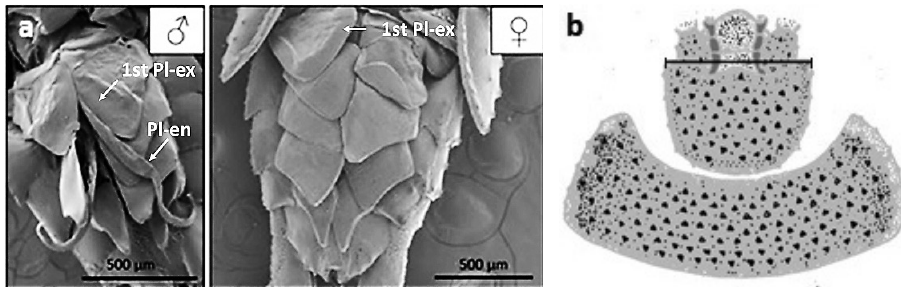
Figure 1. a Sexual dimorphism of Mesoniscus graniger . Scale bar 500 µm. Key: 1 st Pl-ex – first pleopodite- exopodite, Pl-en – pleopodite-endopodite b black line – head-width